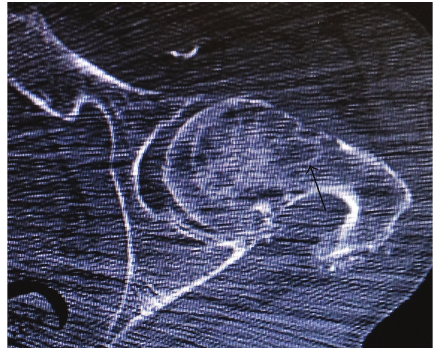
Figure 2: Geode of the left hip probably secondary to